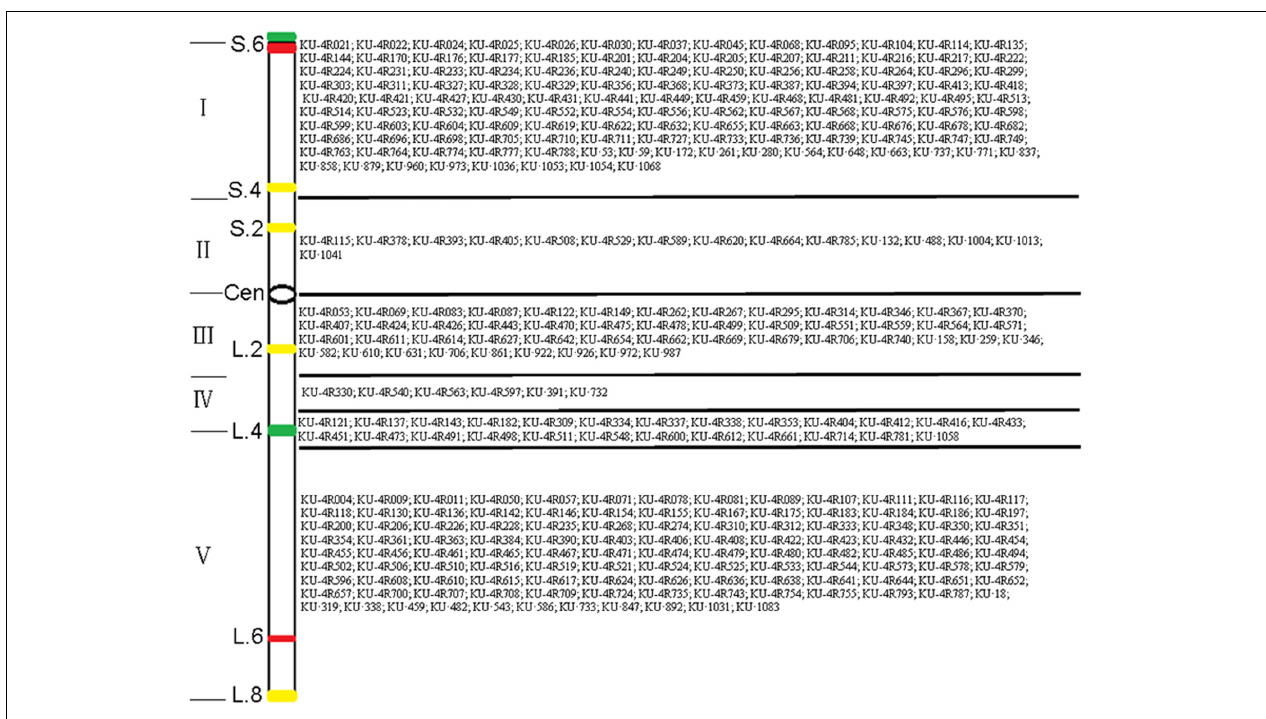
FIGURE 5 | Physical map of 338 4R Ku -specific markers in six regions on 4R Ku chromosome based on PCR amplification using 4R Ku dissection lines. The six regions are divided by the five dark lines. In each region, the names of the 4R Ku -specific markers are listed on the right. The values on the left indicate numbered sites, which were determined by the FISH signals. The Roman numerals on the left indicates the five regions of the 4R Ku chromosome divided by FISH signals. In the schematic diagram, green bands represent Oligo-pSc119.2-1 signals, red bands represent Oligo-pSc200 and Oligo-pSc250 signals, yellow bands represent (AAC) 6 signals, and ‘Cen’ represents centromere.